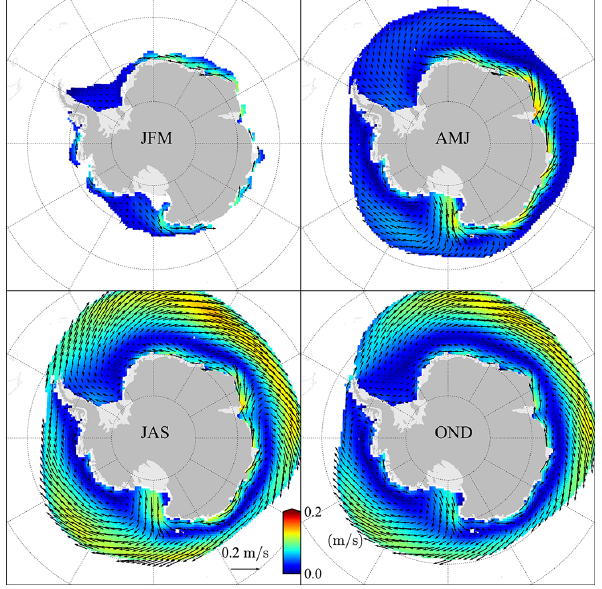
Fig. 6. Mean (1985–2011) seasonal modelled ice motion (ice speed overlain with ice motion vectors). Regions corresponding to a mean ice concentration less than 0.15 are masked in both data sets. JFM: January–March (summer), AMJ: April–June (autumn), JAS: July– September (winter), OND: October–December